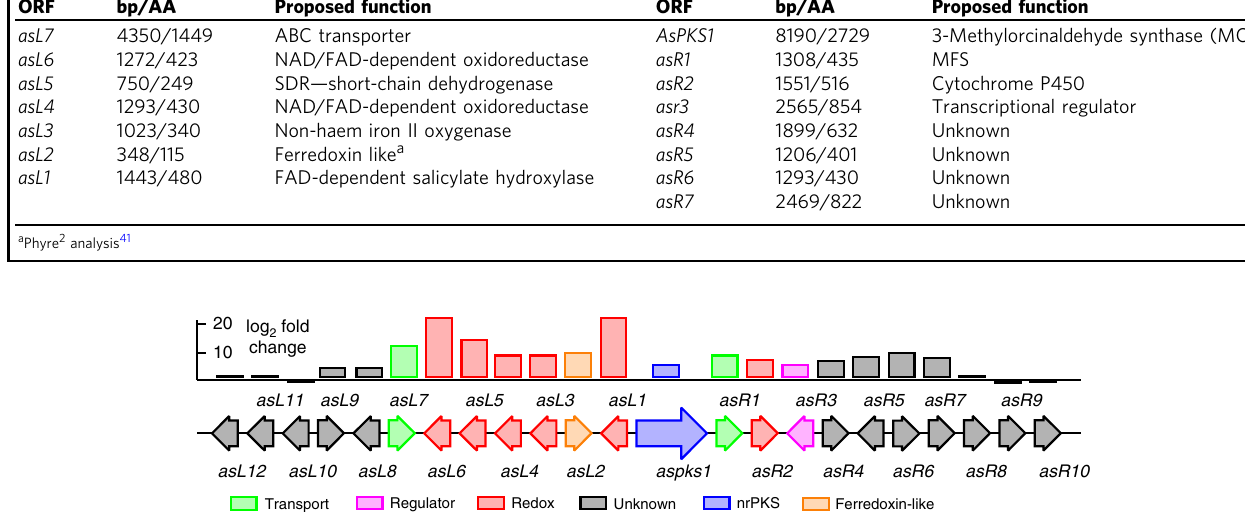
Fig. 3 Transcription analysis of the xenovulene BGC. Approximate values, see Supplementary Table 14 for actual